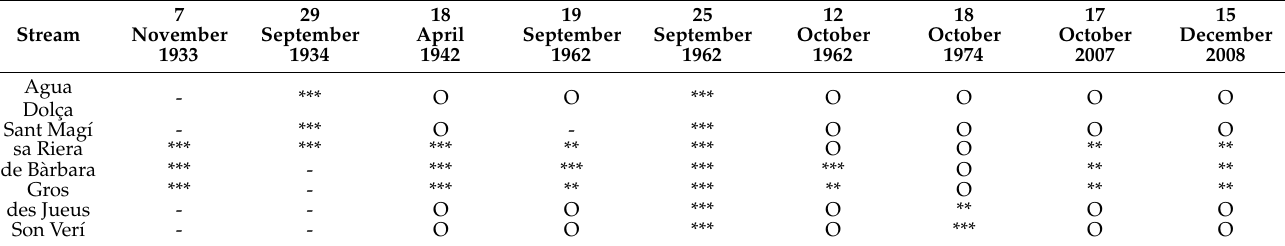
Table 2. Flood events affectation in the 20th century. Source: [35].